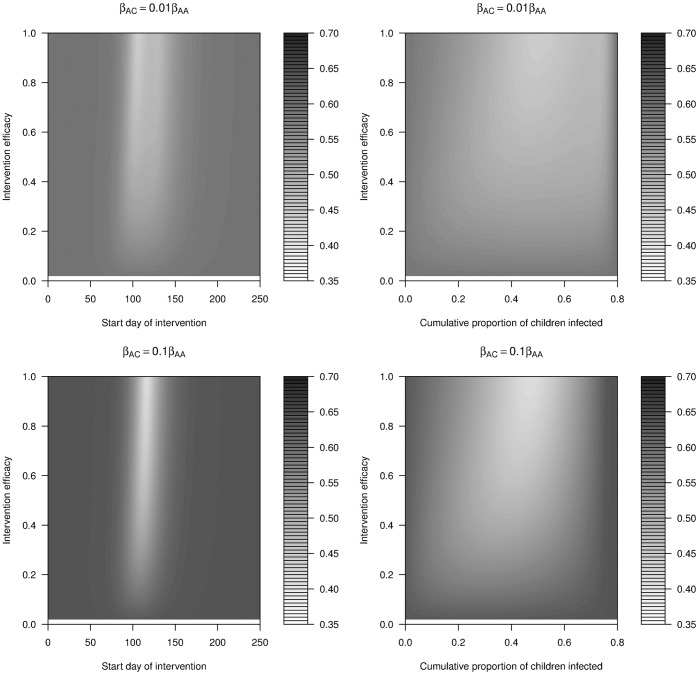
Cumulative attack rate of the whole population (CAW) under 28-days intervention with different levels of efficacy against different time triggers (start days of intervention, left) and population triggers (cumulative proportion of children infected, right).The legend colour panel displays CAW. βAC = 0.01 * βAA; βCA = 0.01 * βCC (upper row); βAC = 0.1 * βAA; βCA = 0.1 * βCC (lower row). All other details are the same as Figure 10. Compared to Figure 10, it is notable that the J-shaped contours of Figure 10 are replaced by vertical minima in Figure 11. In other words, weak interventions that started early would not lead to the optimal outcome if its duration was short.